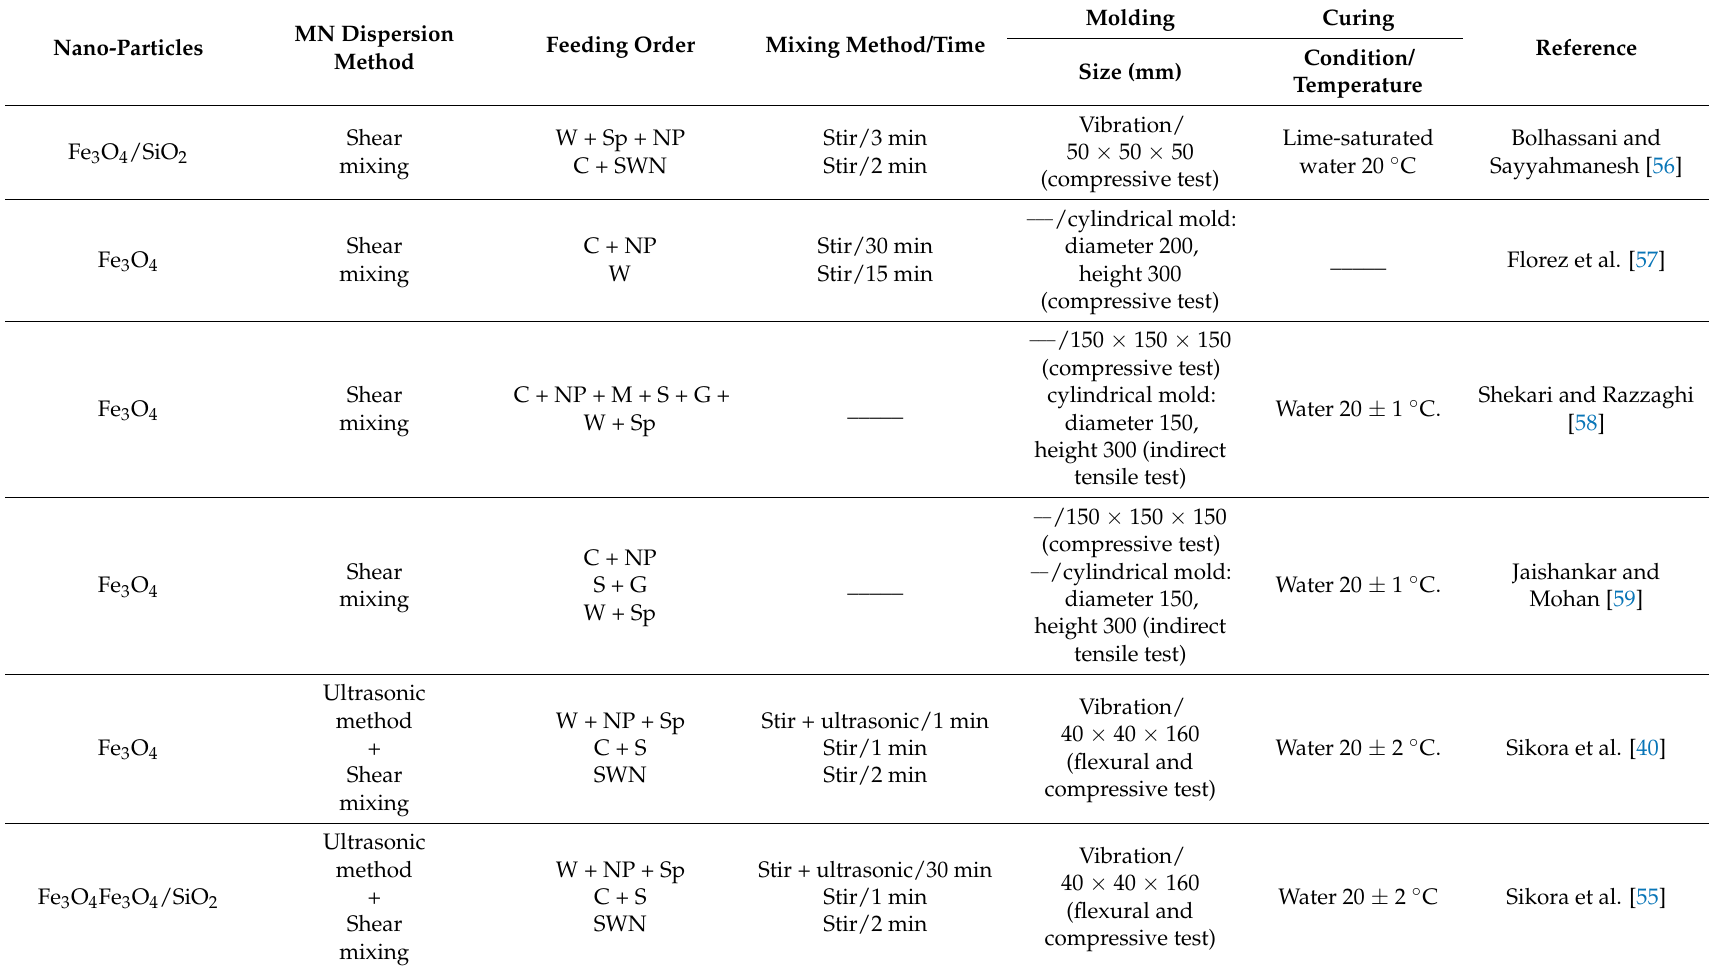
Table 2. Processes available for the production of cement composites with MN